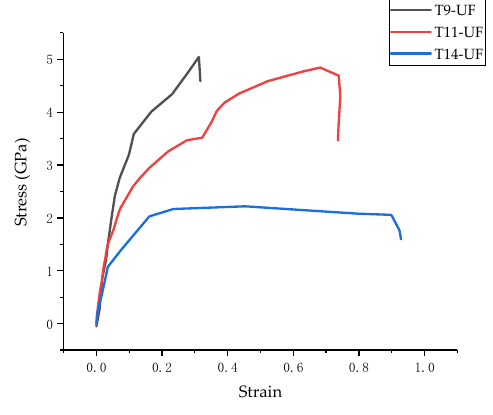
Figure 7. Stress–strain curves of T9-UF, T11-UF, T14-UF.